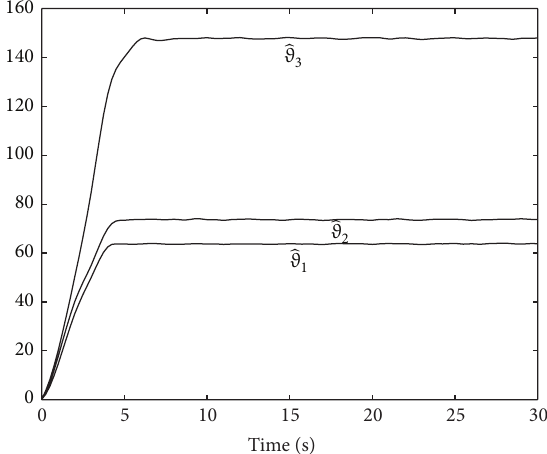
̂𝜗 ̂𝜗 ̂𝜗 1 , 2 , and 3 .